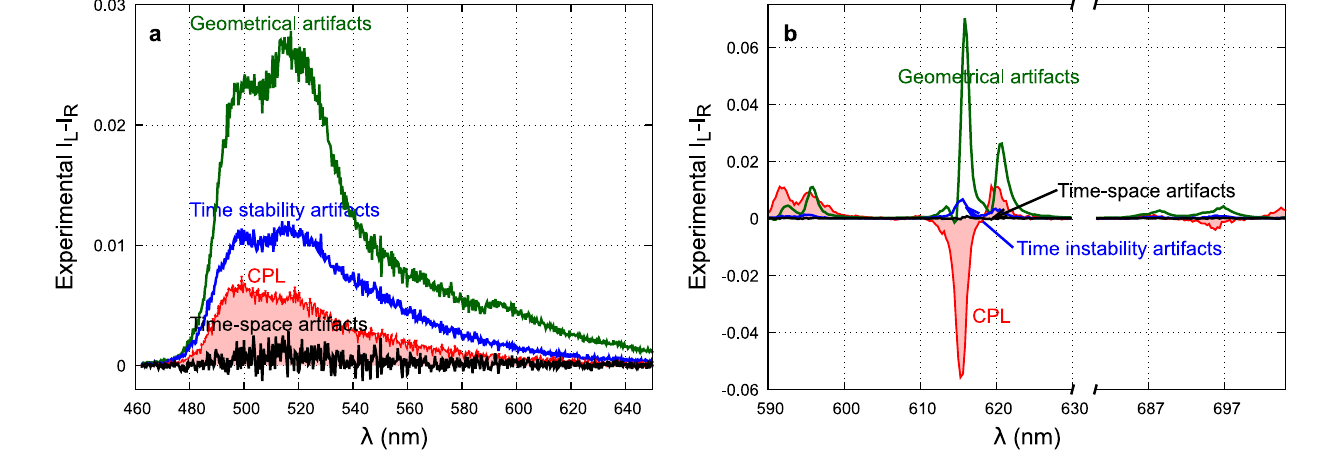
arethesignaldifferencebetweenthetwopolarization-encodedarms:itimagesthe unbalanceoftheopticalpaths.Inblue,thesignaldifferencefortwomeasurements delayed by 20s obtained on the same arm, this is the Δ ϕ light source relative variation. 10s represents the required time to rotate the QWP by 90 ∘ . Black curves result from the spatial-time